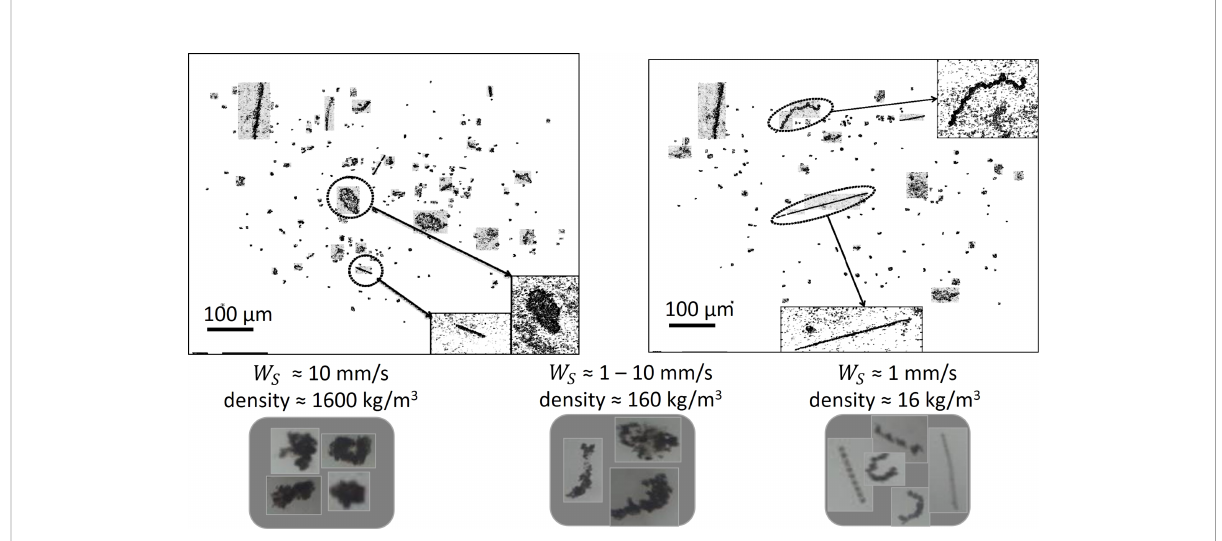
FIGURE 2 Different particles identi fi ed by LISST-HOLO (top fi gures) and underwater camera (bottom pictures) recordings. The indicated settling velocities and derived densities are found by LabSFLOC2 measurements. All the fl ocs illustrated here belong to the size range of 20 - 200 m m. The fl ocs composed of inorganic/organic particles belong to Class 2 (left and middle pictures, some fl ocs on the right picture), whereas the bare algae (strings devoid of mineral sediment that are seen on the right picture) belong to Class